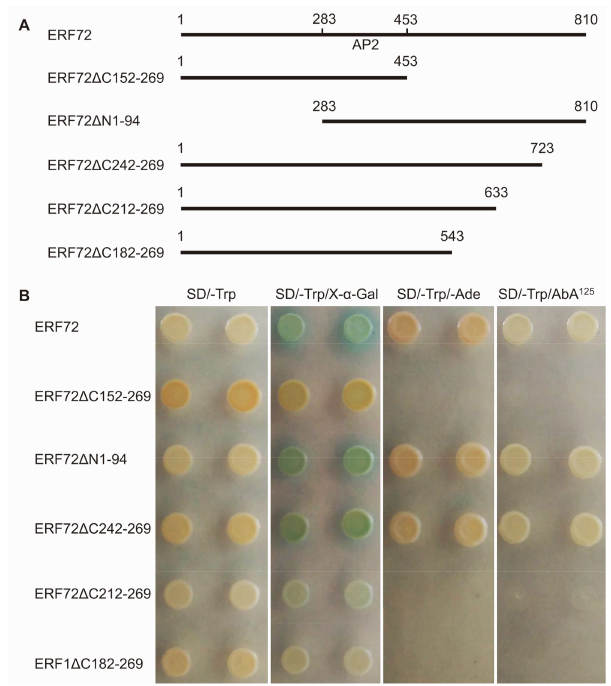
Figure 4. Region aa212-aa241 is the activated domain in MeERF72 protein. ( A ) Different deletion vectors of ERF72 protein: ERF72 ∆ C152-269 means that aa152 to aa269 is deleted from C-terminus, ERF72 ∆ N1-94 means that aa1-aa94 is deleted from N-terminus; ( B ) Activation of reporter genes by different deletions of ERF72 protein (SD/-Trp/AbA 125 contains 125 ng/mL AbA).